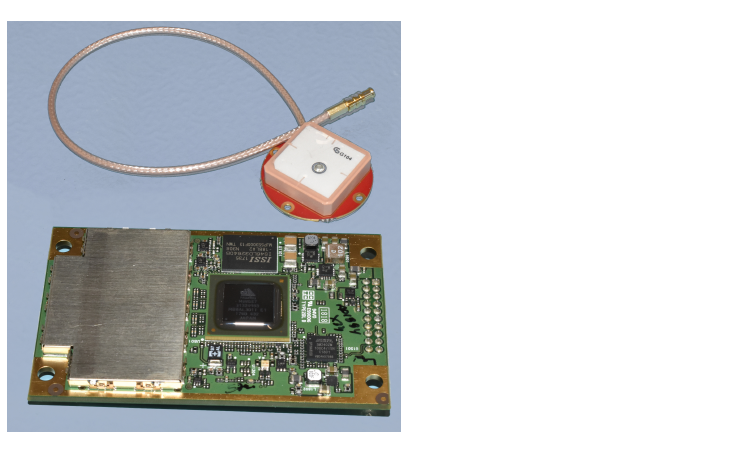
Figure 12. Novatel OEM719 GNSS module and Tallysman TW1322